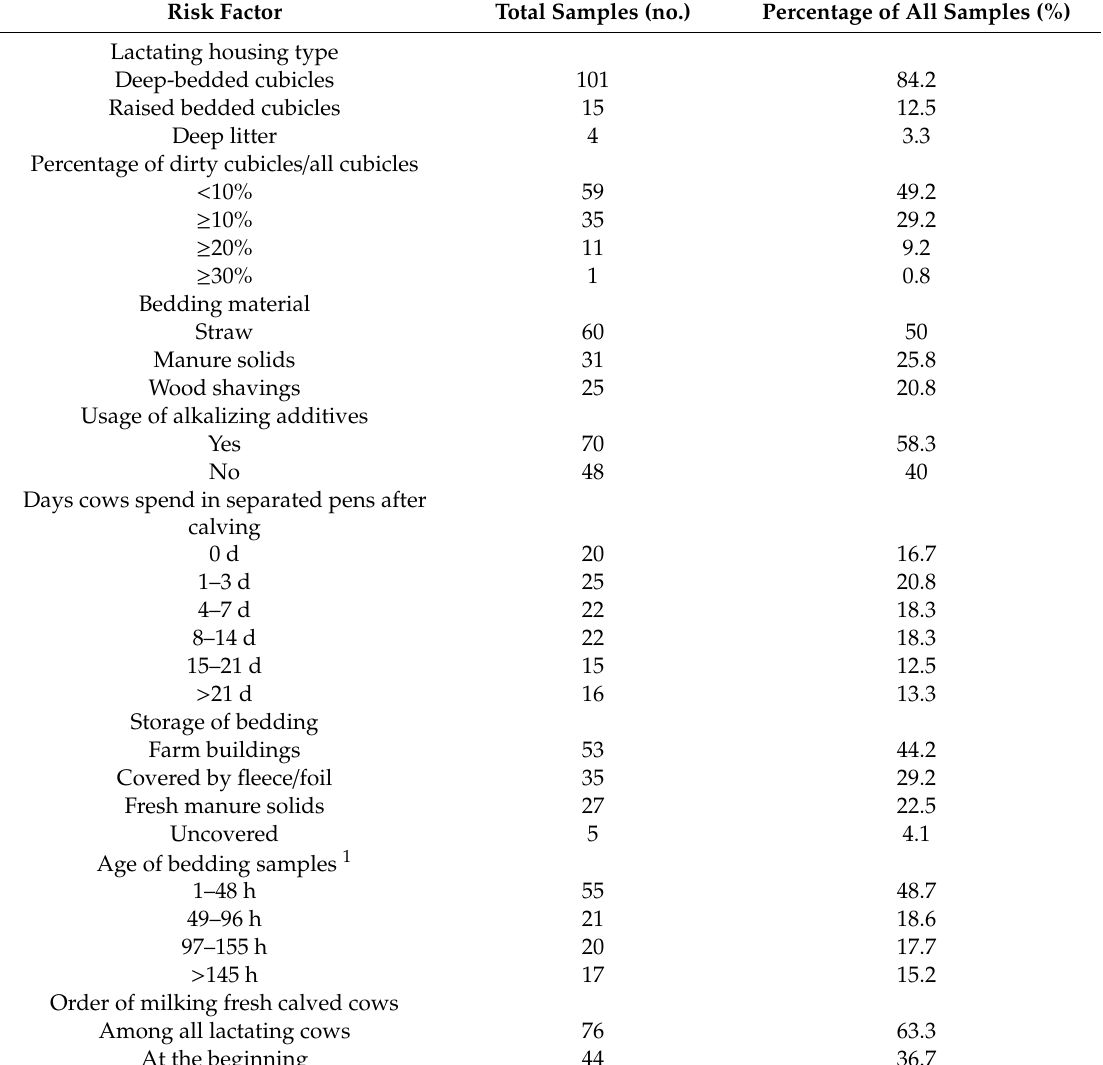
Table A2. Farm-level-associated risk factors and their percentage of all farm visits considered in the univariate analysis of their associations with teat-skin bacterial loads of aerobic mesophilic counts, esculin-positive streptococci and coliform